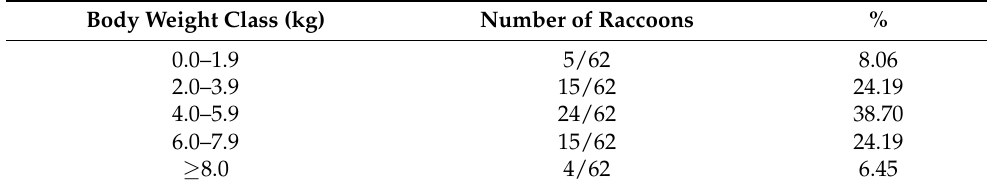
Table 1. Distribution of the 62 raccoon carcasses in classes of body